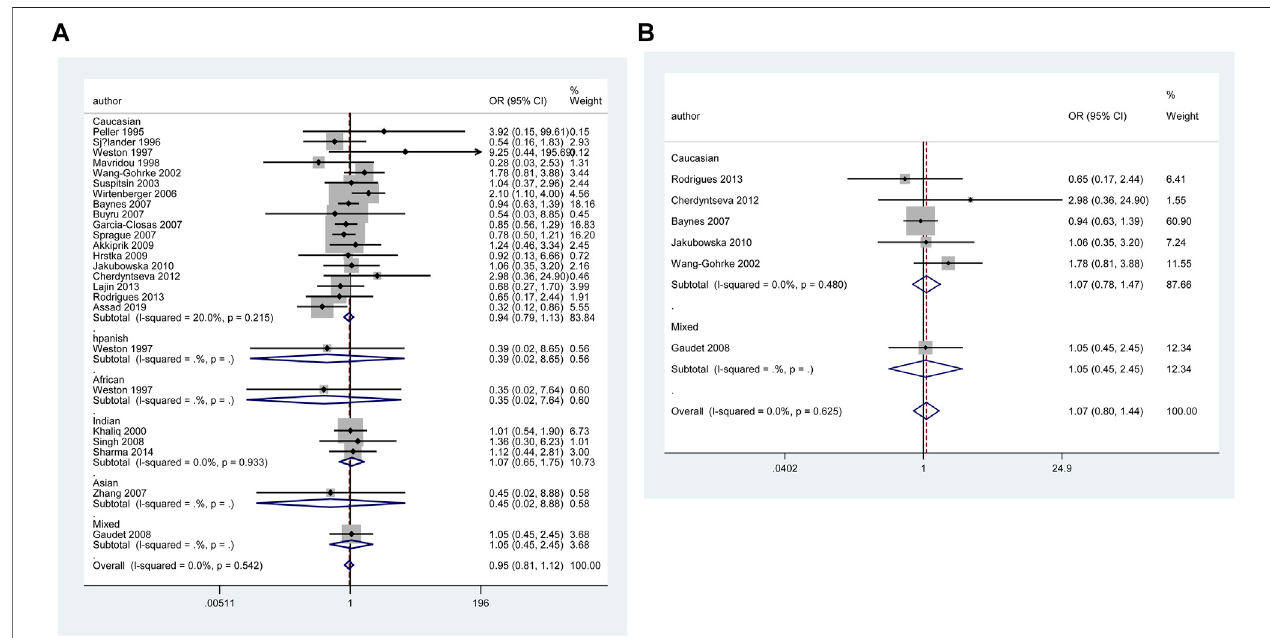
FIGURE 6 | Forest plot of the association between TP53 IVS6+62A > G polymorphism and BC risk in ethnicity subgroup analysis (GG vs. CC + CG) [ (A) : Overall analysis; (B) : Sensitivity analysis].